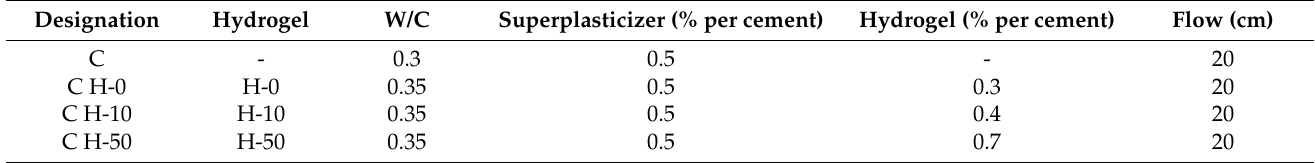
Table 3. Mix designs and the flow value of the cement